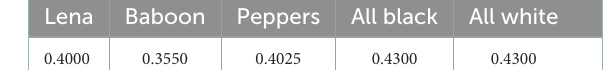
TABLE 9 Fixed point ratio (FPR) for various pairs of plain and cipher images. Lena Baboon Peppers All black All white 0.4000 0.3550 0.4025 0.4300